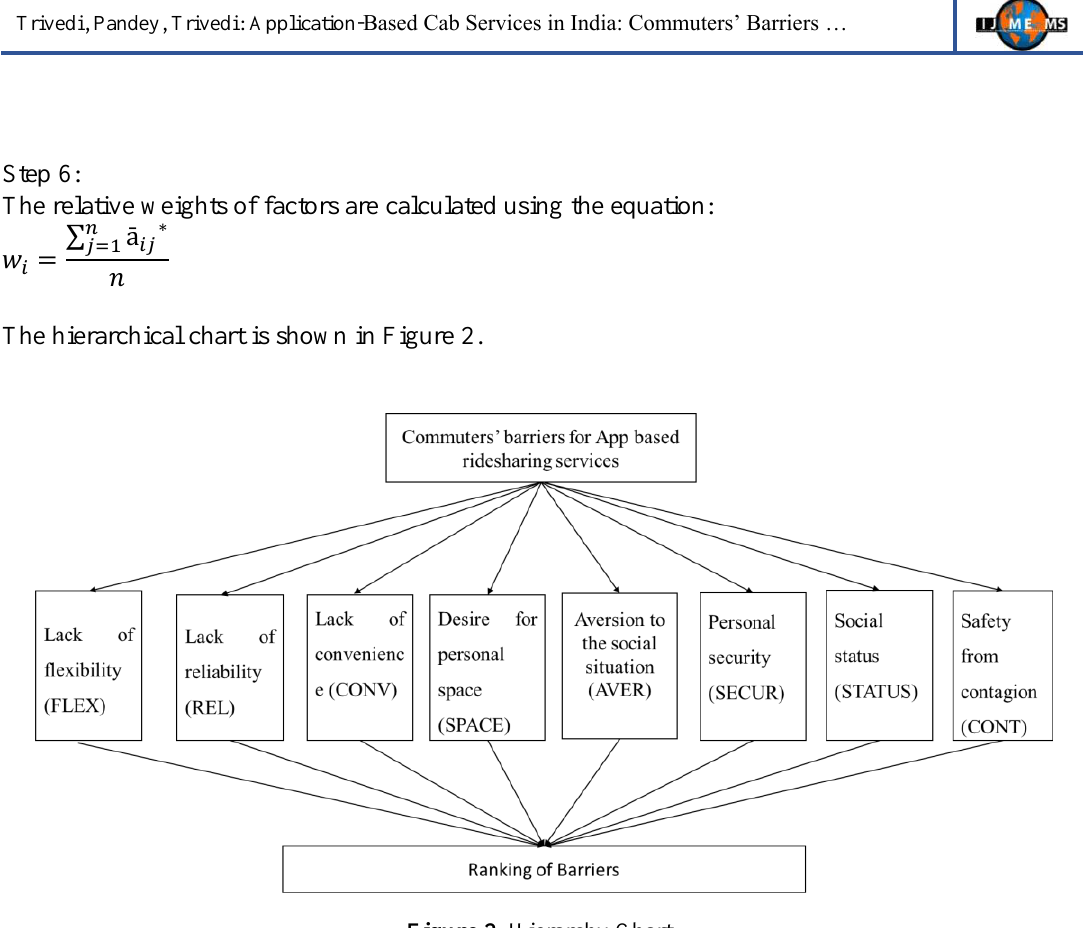
Figure 2. Hierarchy Chart.